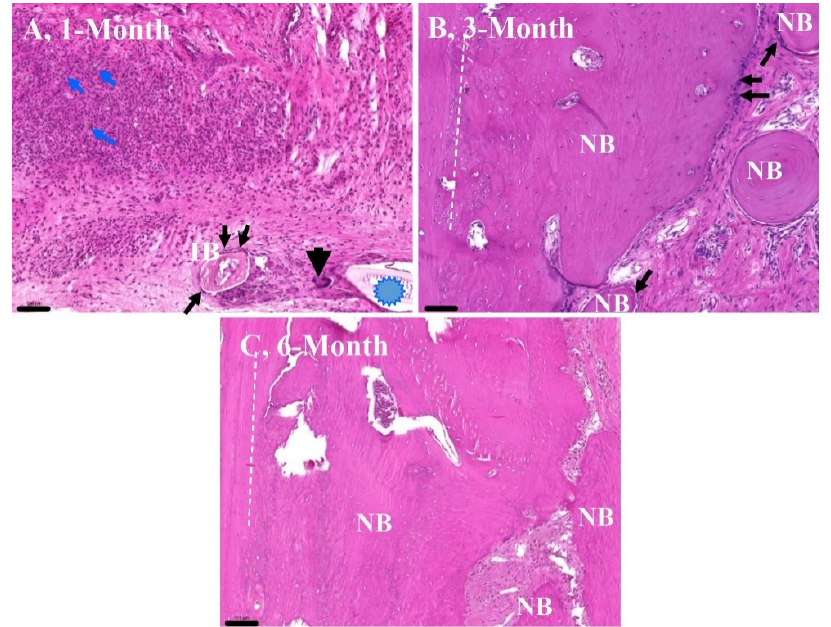
Figure 11. Images of the representative hematoxylin–eosin (HE)-stained tissue sections of formalin- fixed and decalcified samples obtained from the rat critical size defect model on rat calvaria bone. Magnifications and scale bars for all images are 100× and 100 μ m, respectively. IB, immature bone; NB, new bone. White dashed lines highlight the transition of the original bones (left) to the newly formed bones (right). In this follow-up study, the tissues were collected at the end of the first ( A ), third ( B ), and sixth months ( C ), respectively. Blue arrows indicate active inflammation with the presence of exogenous compounds. Blue asterisk shows fibrous granulation tissue formation. Thin black arrows show sites surrounded by an increased number of osteoblasts. The thick arrow points to the multinuclear macrophage.